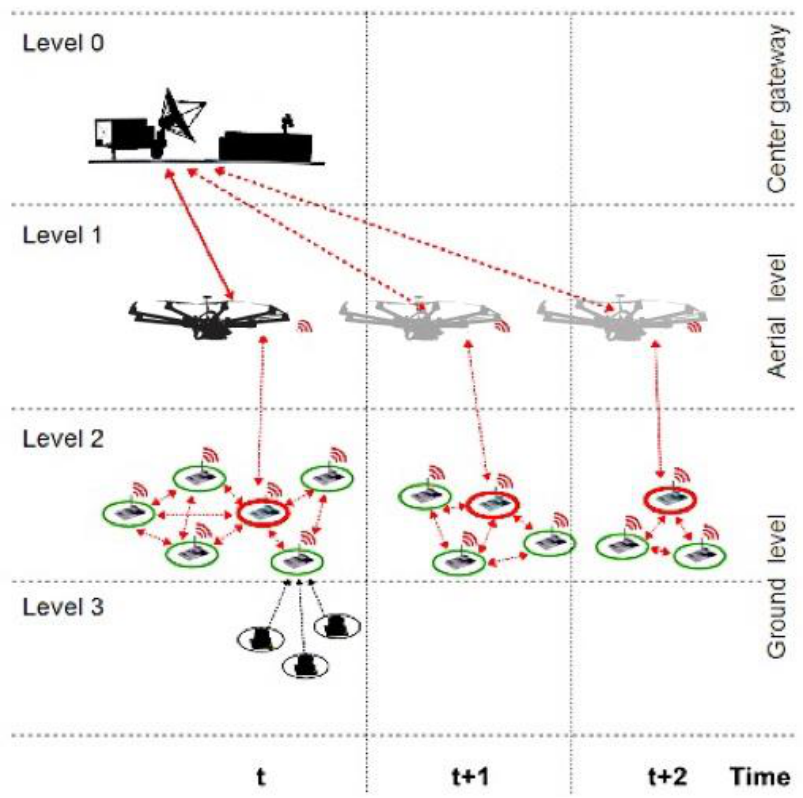
Figure 1. Hybrid UAV-WSN large scale monitoring system concept.